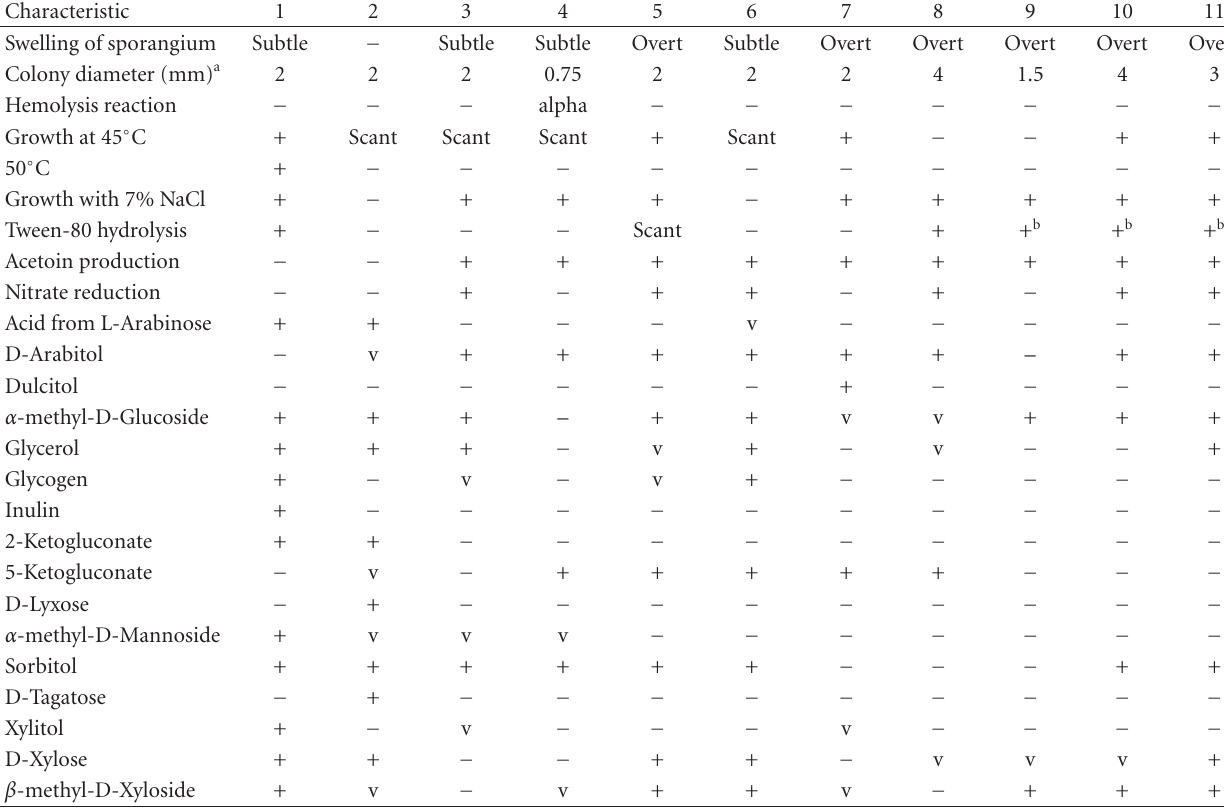
Table 4: Comparison of di ff erential phenotypic traits for strain CBD 118, eight closely related strains, and most closely related type strains. Strains: 1, Bacillus circulans ATCC 4513 T ; 2, Bacillus nealsonii DSM 15077 T ; 3, CBD 118; 4, OSS 25; 5, P307; 6, P308; 7, C4T1F3B3; 8, IAFILS6; 9, AD5A; 10, U4A; 11, ADP4II. a Approximate mean diameter of 5 well-isolated colonies grown 24 + 2h, 30 ◦ C on tryptic soy agar plates. b Larger, more opaque zone of hydrolysis for these strains. Subtle, < 50% increase in diameter of sporangium for preponderance of cells field − 1 ; Overt, ≥ 50% increase in diameter of sporangium for ≥ 25% of cells field − 1 ; +: positive; − : negative; Scant: optical density just above threshold for unaided detection; v: variable, indicating both + and − reactions for strain in ≥ 4 tests. Scant and v were di ff erentiated